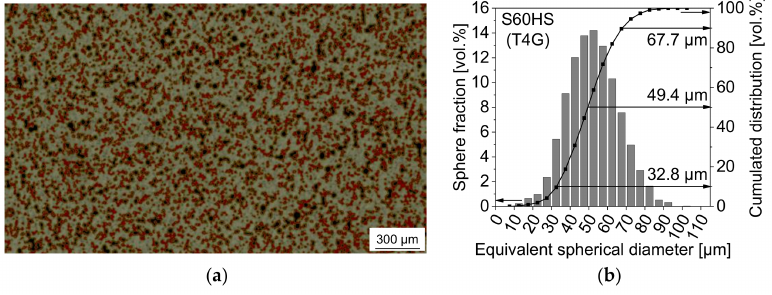
Figure 3. Tomographic imaging of the syntactic TRIP steel matrix foam with 40 vol % S60HS: ( a ) reconstructed 2D image (pale grey—matrix, cenospheres: red—solid part, black—cavities/pores); ( b ) sphere size distribution (using equivalent spherical diameter,